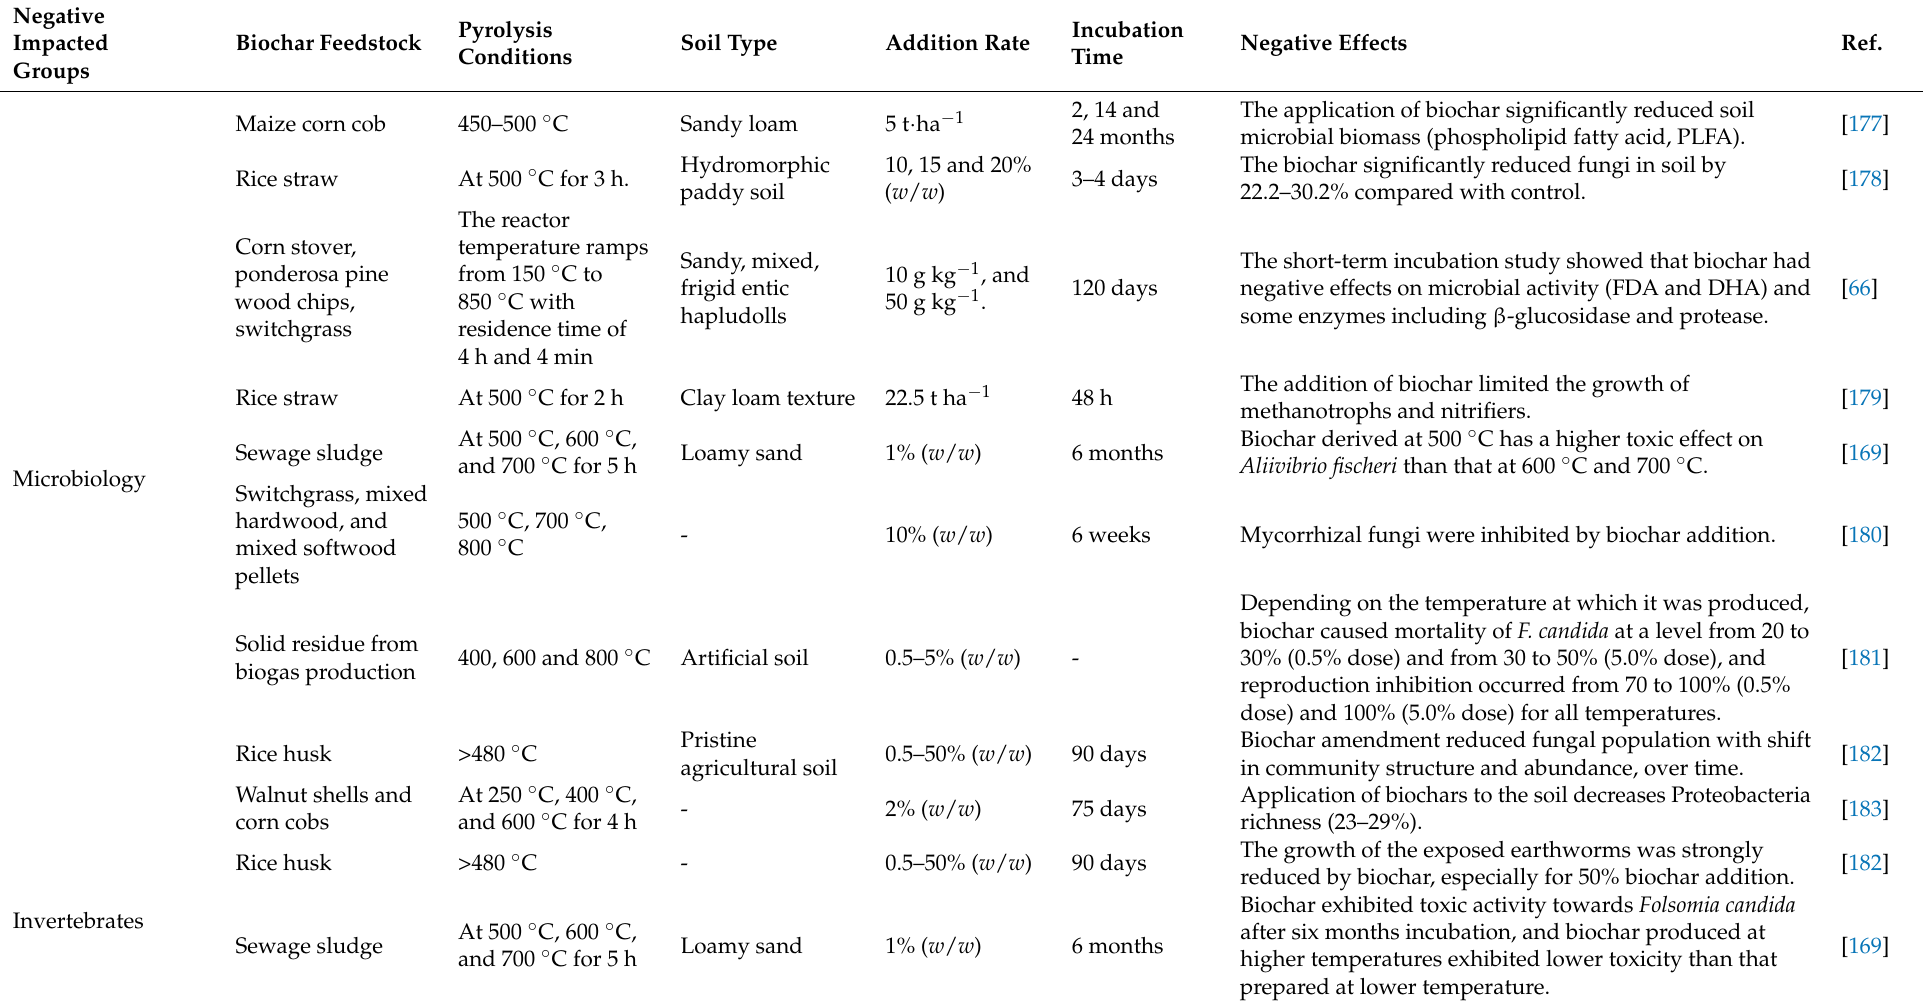
Table 3. The negative effect of biochar on soil